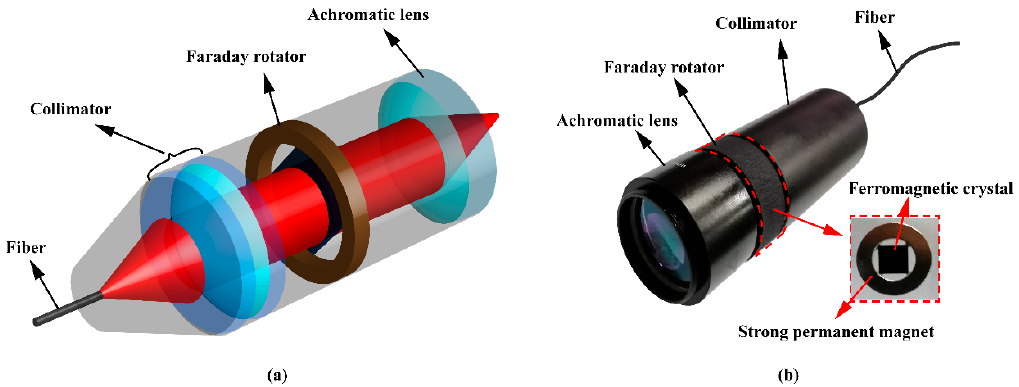
Figure 2. The self-designed probe with a built-in Faraday rotator: ( a ) the schematic diagram; ( b ) a picture of the probe and Faraday rotator details.